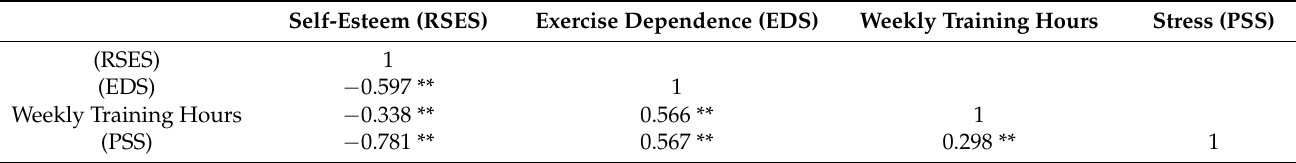
Table 2. Correlation